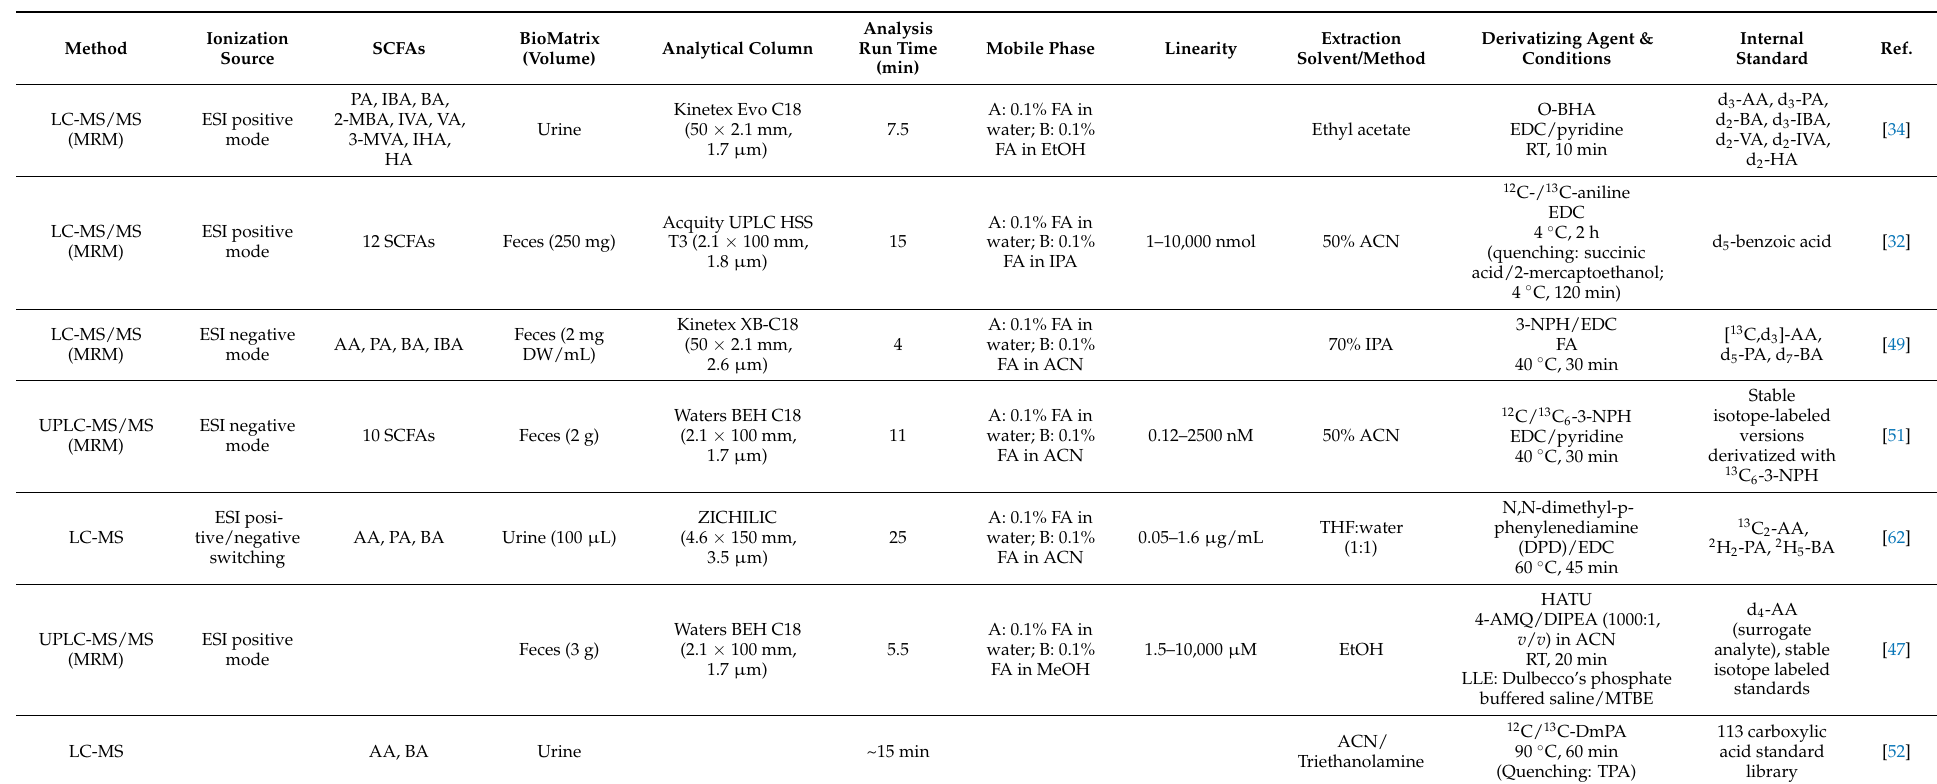
Table 2. SCFAs quantified in human feces and